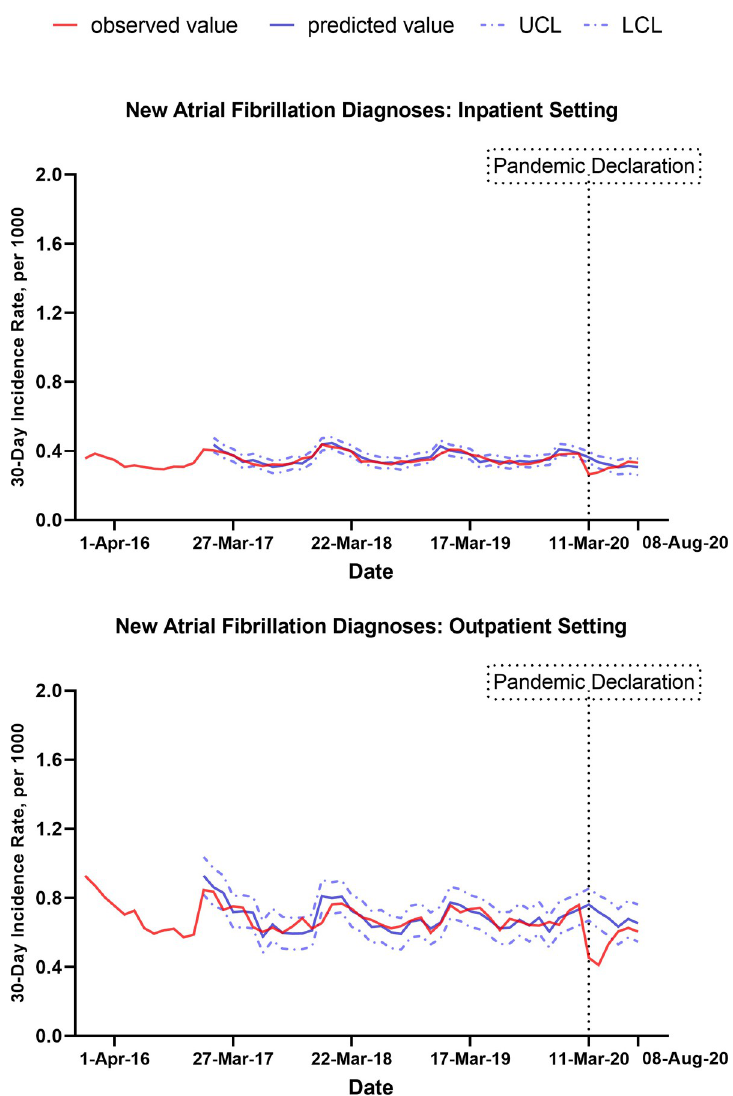
Fig 2. Observed and predicted new atrial fibrillation diagnoses by setting. Abbreviations: UCL, upper confidence limit; LCL, lower confidence limit. The lower left panel shows trends in new atrial fibrillation diagnoses per 1000 individuals in Hispanic individuals for 30-day intervals, from 01/02/2016 to 09/06/2020. The lower right panel shows trends in new atrial fibrillation diagnoses per 1000 individuals in individuals of other races for 30-day inter- vals, from 01/02/2016 to 09/06/2020. Solid red lines represent observed values. Solid blue lines represent predictions from ARIMA models the absence of the COVID-19 pandemic. In other words, they represent trends in AF diagnosis that would have been observed if there had not been a change in AF diagnoses following the COVID-19 pandemic. Dashed blue lines repre- sent confidence intervals. The estimated decrease in new AF diagnoses was significant across both sex subgroups, but the magnitude of the decrease did not differ across sex groups, as shown in S2 Fig and S4 Table.